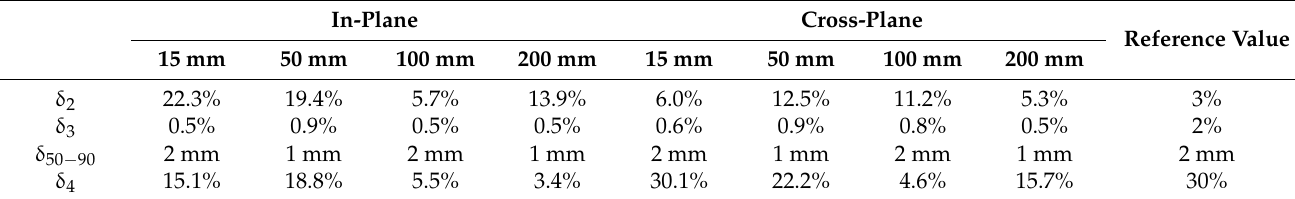
Table 3. Beam profile analysis of measured and simulated values for Varian Clinac 6MV: Data of 10 cm × 10 cm field size were analyzed at 15 mm, 50 mm, 100 mm, and 200 mm depths. Each part